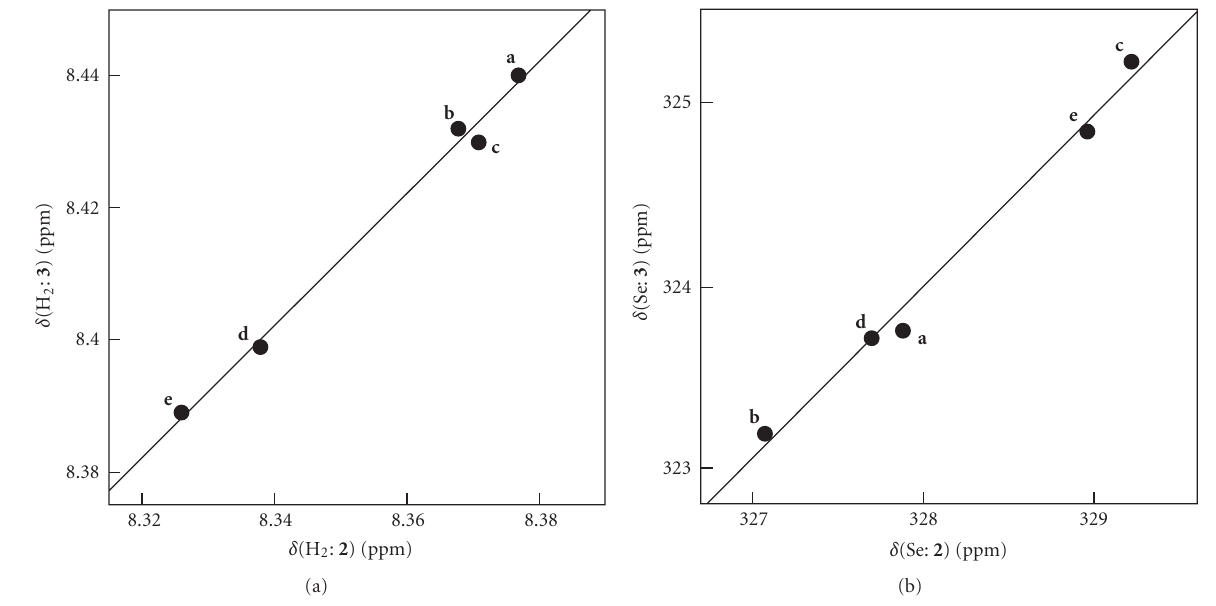
Figure 3: Plots of δ (H 2 : 3 ) versus δ (H 2 : 2 ) (a) and δ (Se: 3 ) versus δ (Se: 2 )